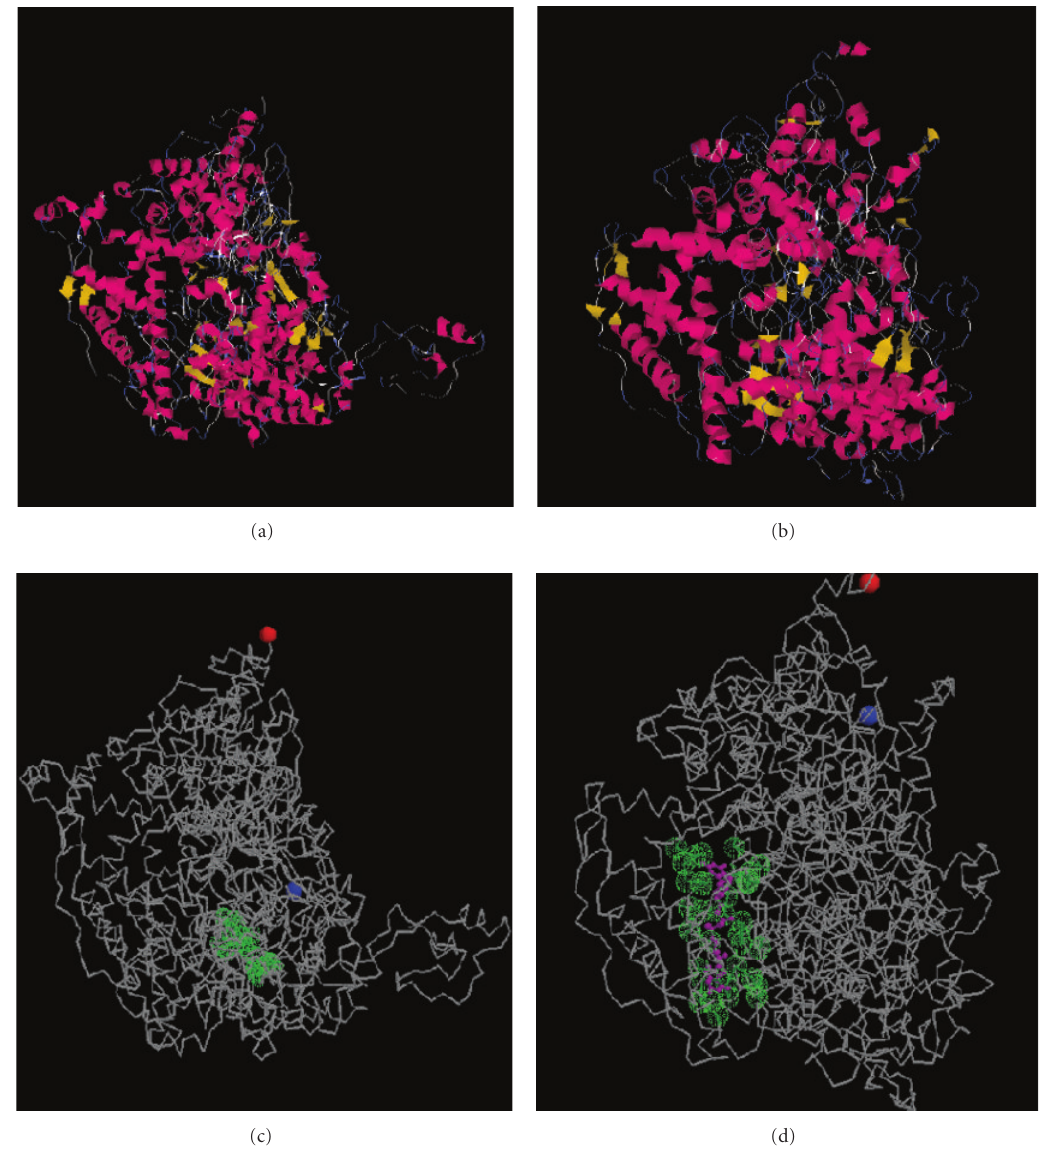
Figure 3: Predicted models of human (a) and mouse (b) NAIPs. (c) indicates predicted binding sites on human NAIP; (d) indicates predicted binding sites on mouse